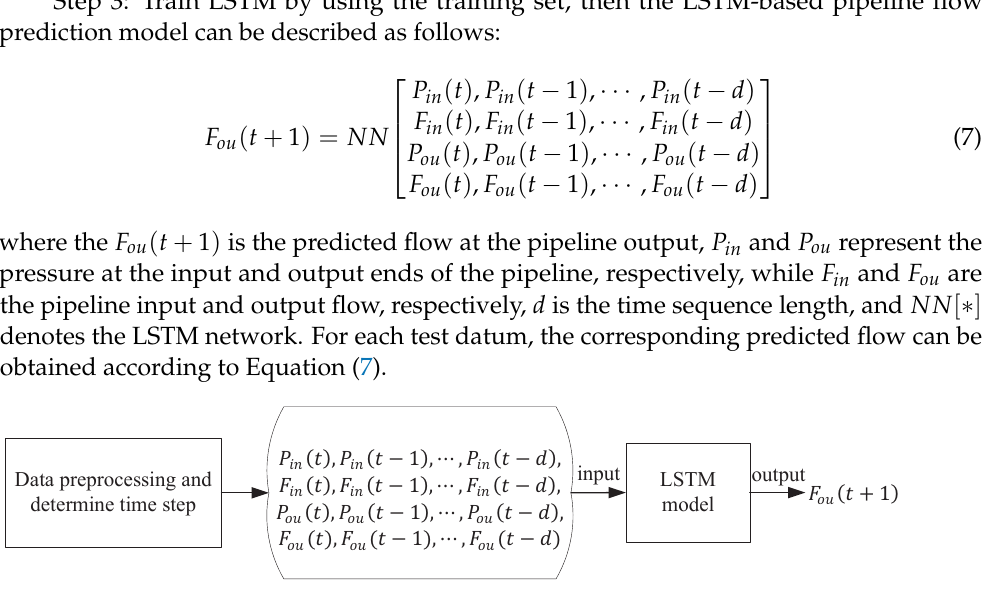
Figure 4. The overall workflow of the pipeline flow prediction